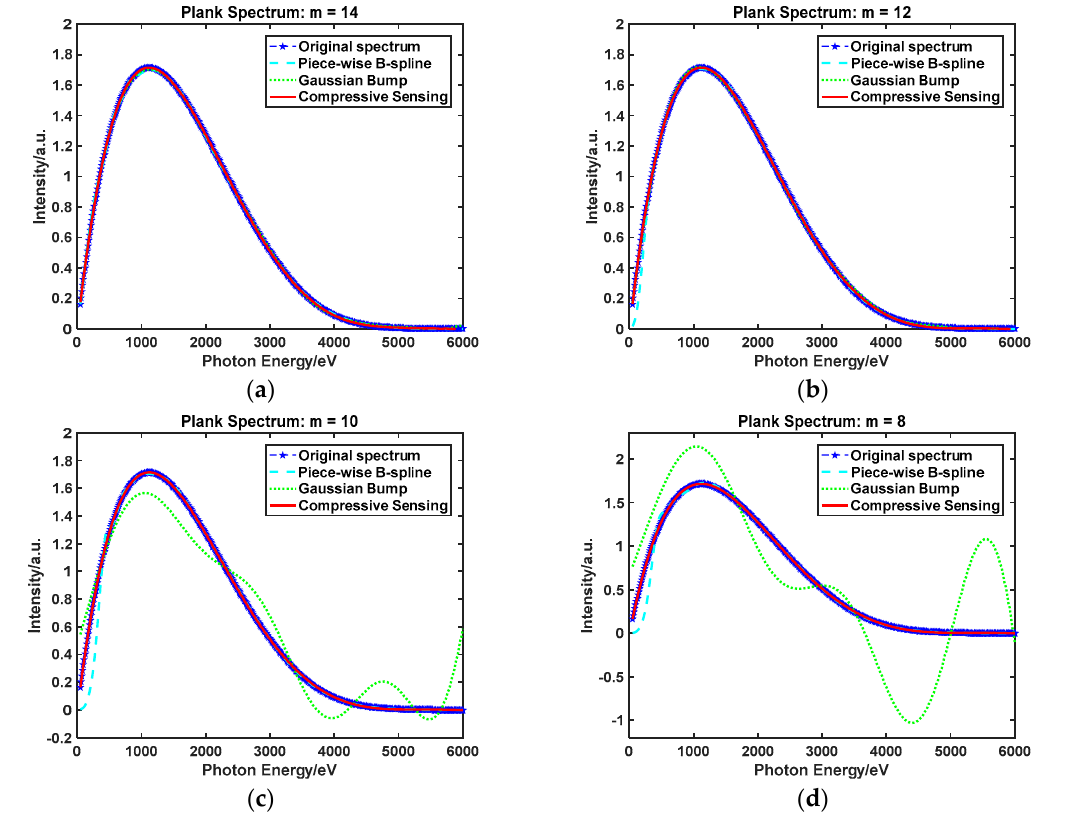
Figure 5. Plank spectrum recovery performance with three different spectrum unfolding methods as the measurements decrease. ( a ) The number of detection channels is 14. ( b ) The number of detection channels is 12. ( c ) The number of detection channels is 10. ( d ) The number of detection channels is 8.